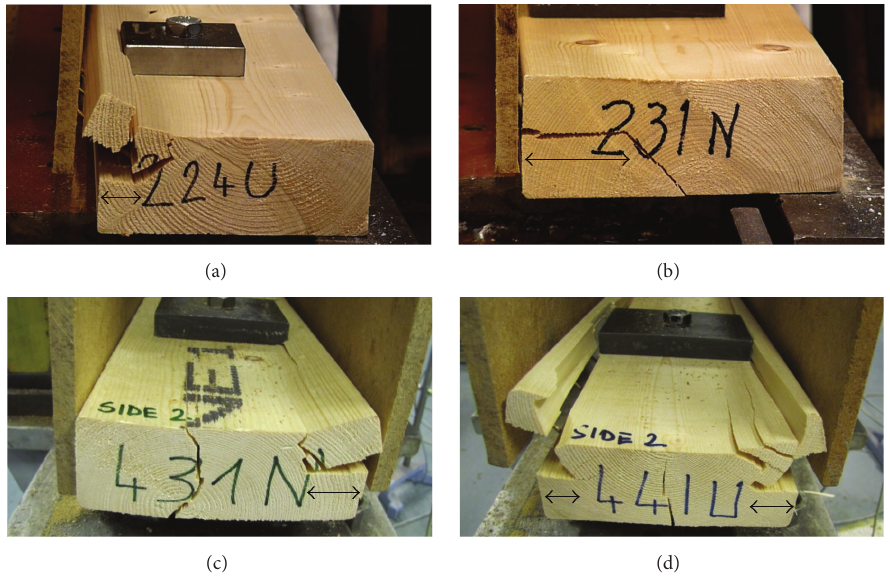
Figure 11: Examples of length of horizontally propagating cracks measured on the test specimens.